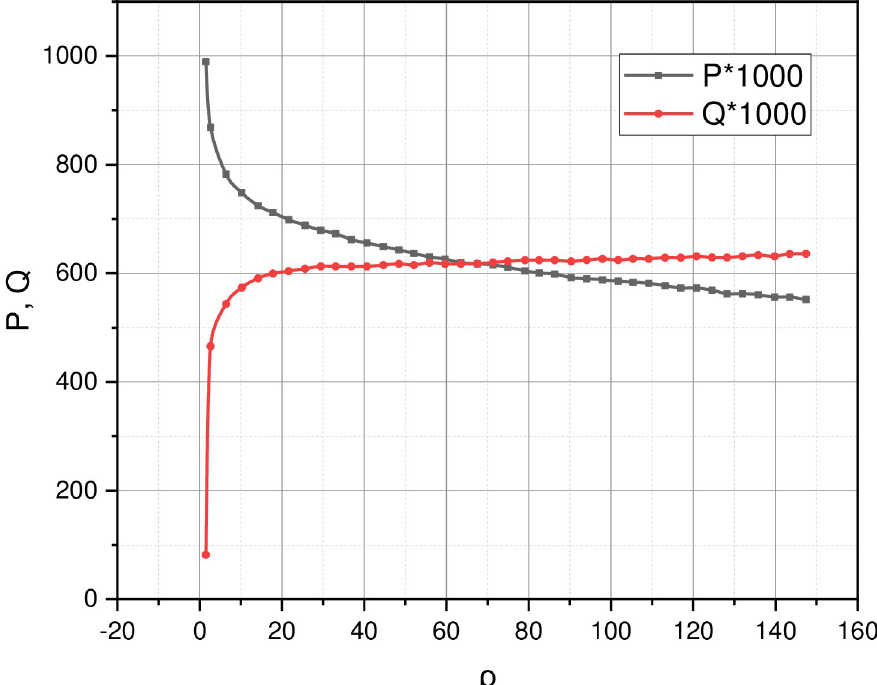
Fig 2. Functional dependences { P , Q } = f ( ρ ) calculated based on model (17) for the obtained experimental data.